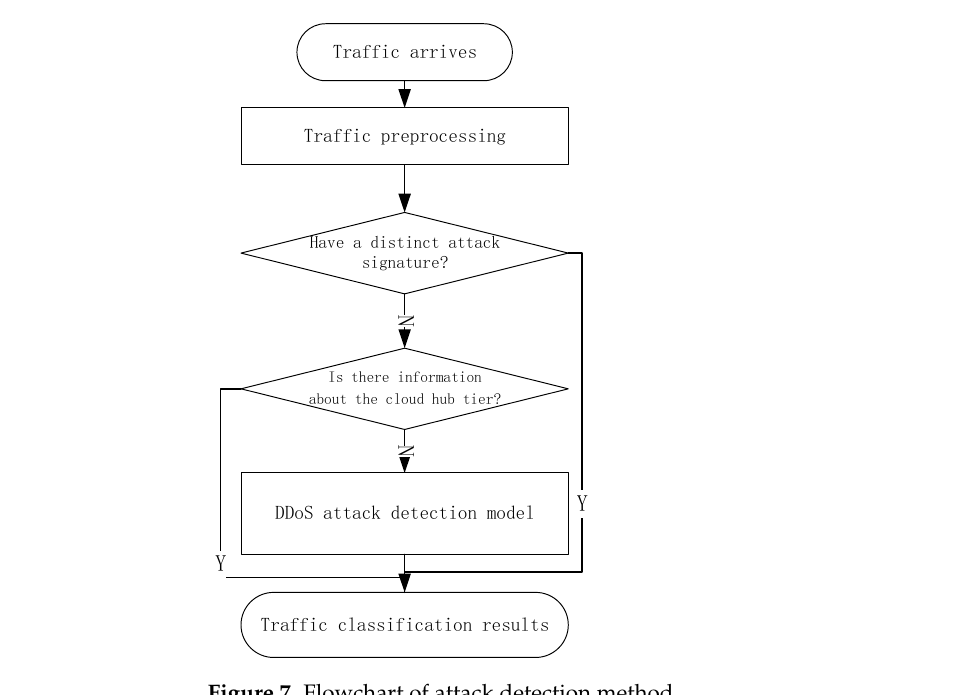
Figure 7. Flowchart of attack detection method.